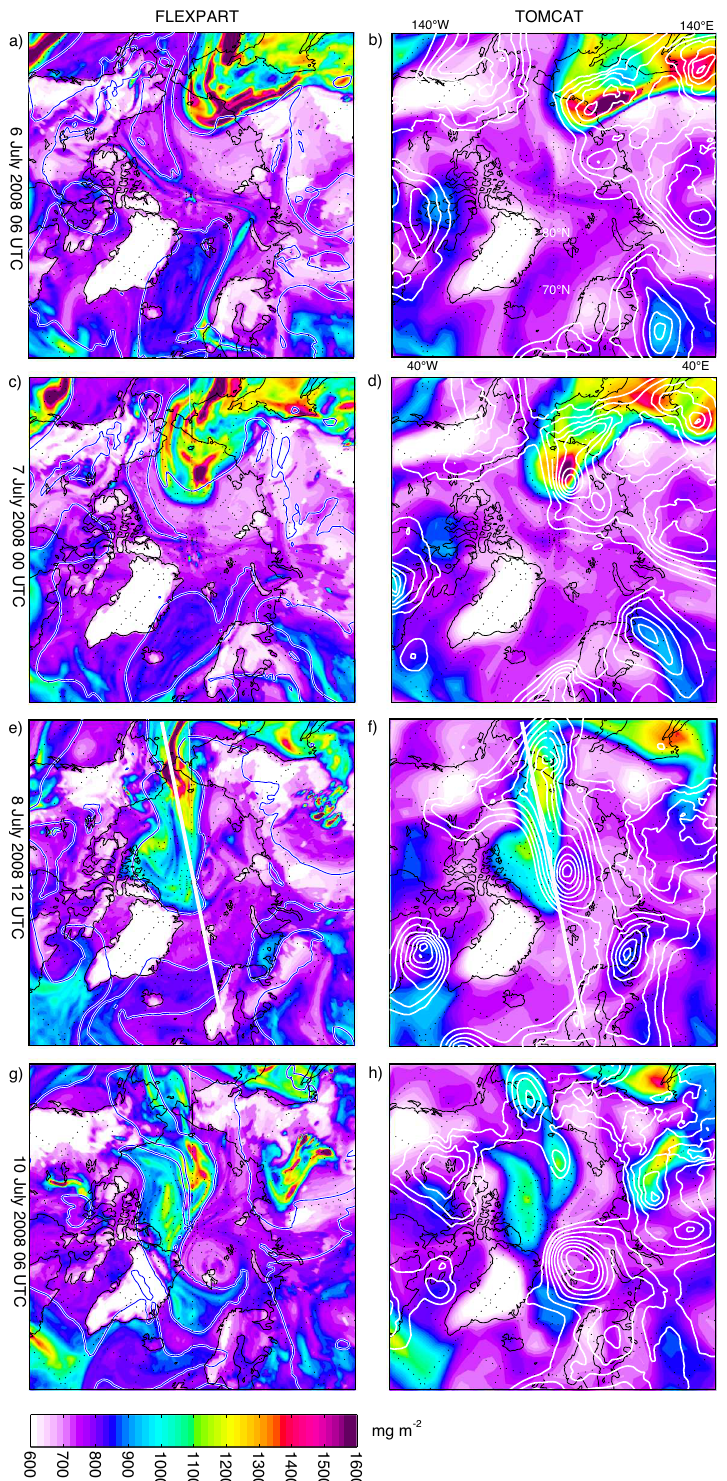
Fig. 4. As Fig. 2, but for the period 6 July 2008 06:00UTC to 10 July 2008 06:00UTC. Thick white line denotes the transect shown in Fig. 5.